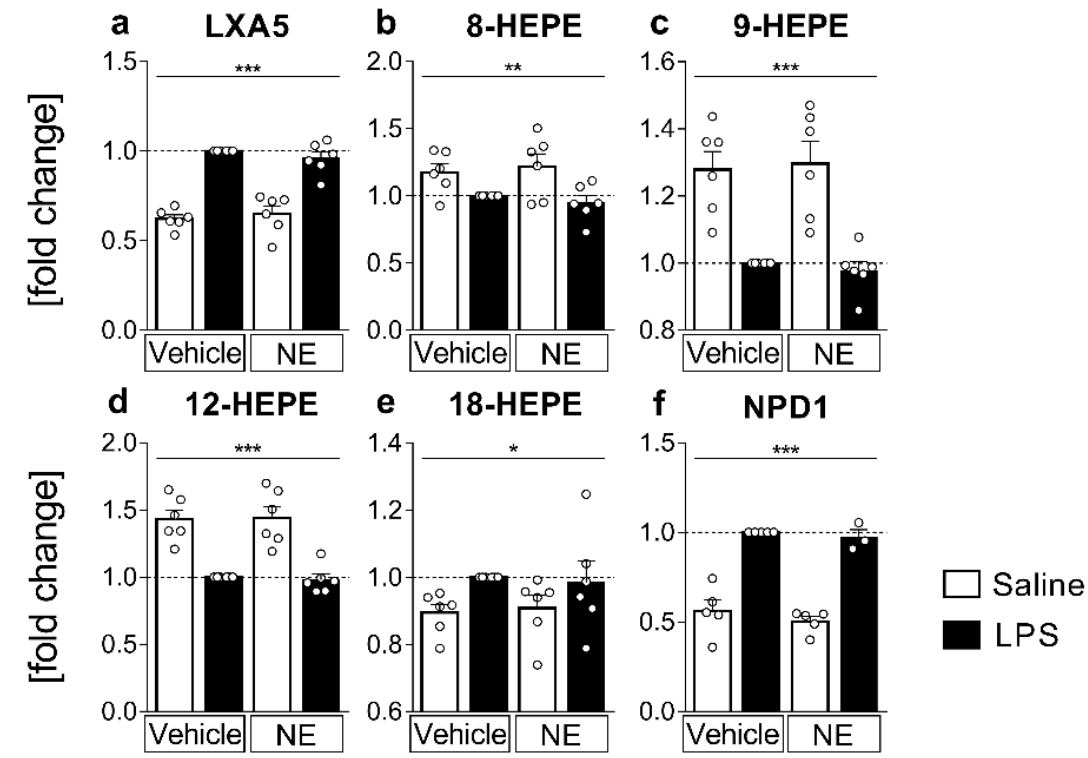
Figure 4. n-3 lipid mediators and metabolites from supernatants: detection and quantification of n-3 lipid mediators and metabolites derived from eicosapentaenoic acid (EPA, ( a – e )) or docosahexaenoic acid (DHA, ( f )) from supernatants using LC-MS/MS. Primary sensory circumventricular organ (sCVO) cell cultures were stimulated with lipopolysaccharide (LPS, 10 µ g/mL) or saline and simultaneously treated with norepinephrine (NE, 1 µ mol/L) or vehicle for 4 h. For every sample set, metabolite concentrations are plotted as fold change to the LPS-stimulated sample (LPS+vehicle) for each of the six independent experiments. The EPA metabolites LXA5 (Lipoxin A5, ( a )) and 18-HEPE (hydroxy-eicosapentaenoic acid, ( e )) were elevated in supernatants of LPS-stimulated cells, whereas 8-HEPE ( b ), 9-HEPE ( c ), 12-HEPE ( d ) levels were reduced due to LPS-stimulation when compared to controls. DHA-derived NPD1 (neuroprotectin D1, ( f )) showed LPS-induced increase. n = 6 per group, two-factorial ANOVA, Bonferroni post hoc test, * main effect LPS stimulation; * p < 0.05, ** p < 0.01, *** p <